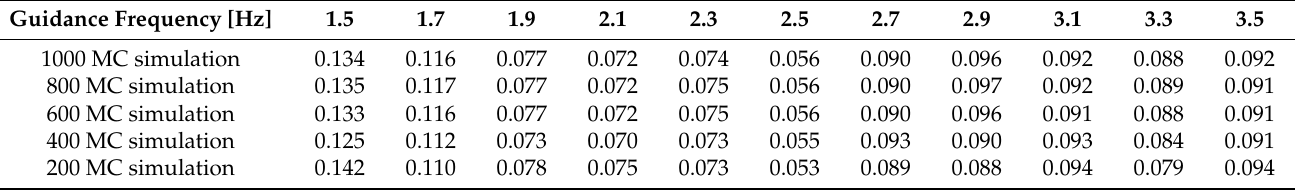
Table 4. The coefficient of variation for the first harmonic of different numbers of MC simulations.